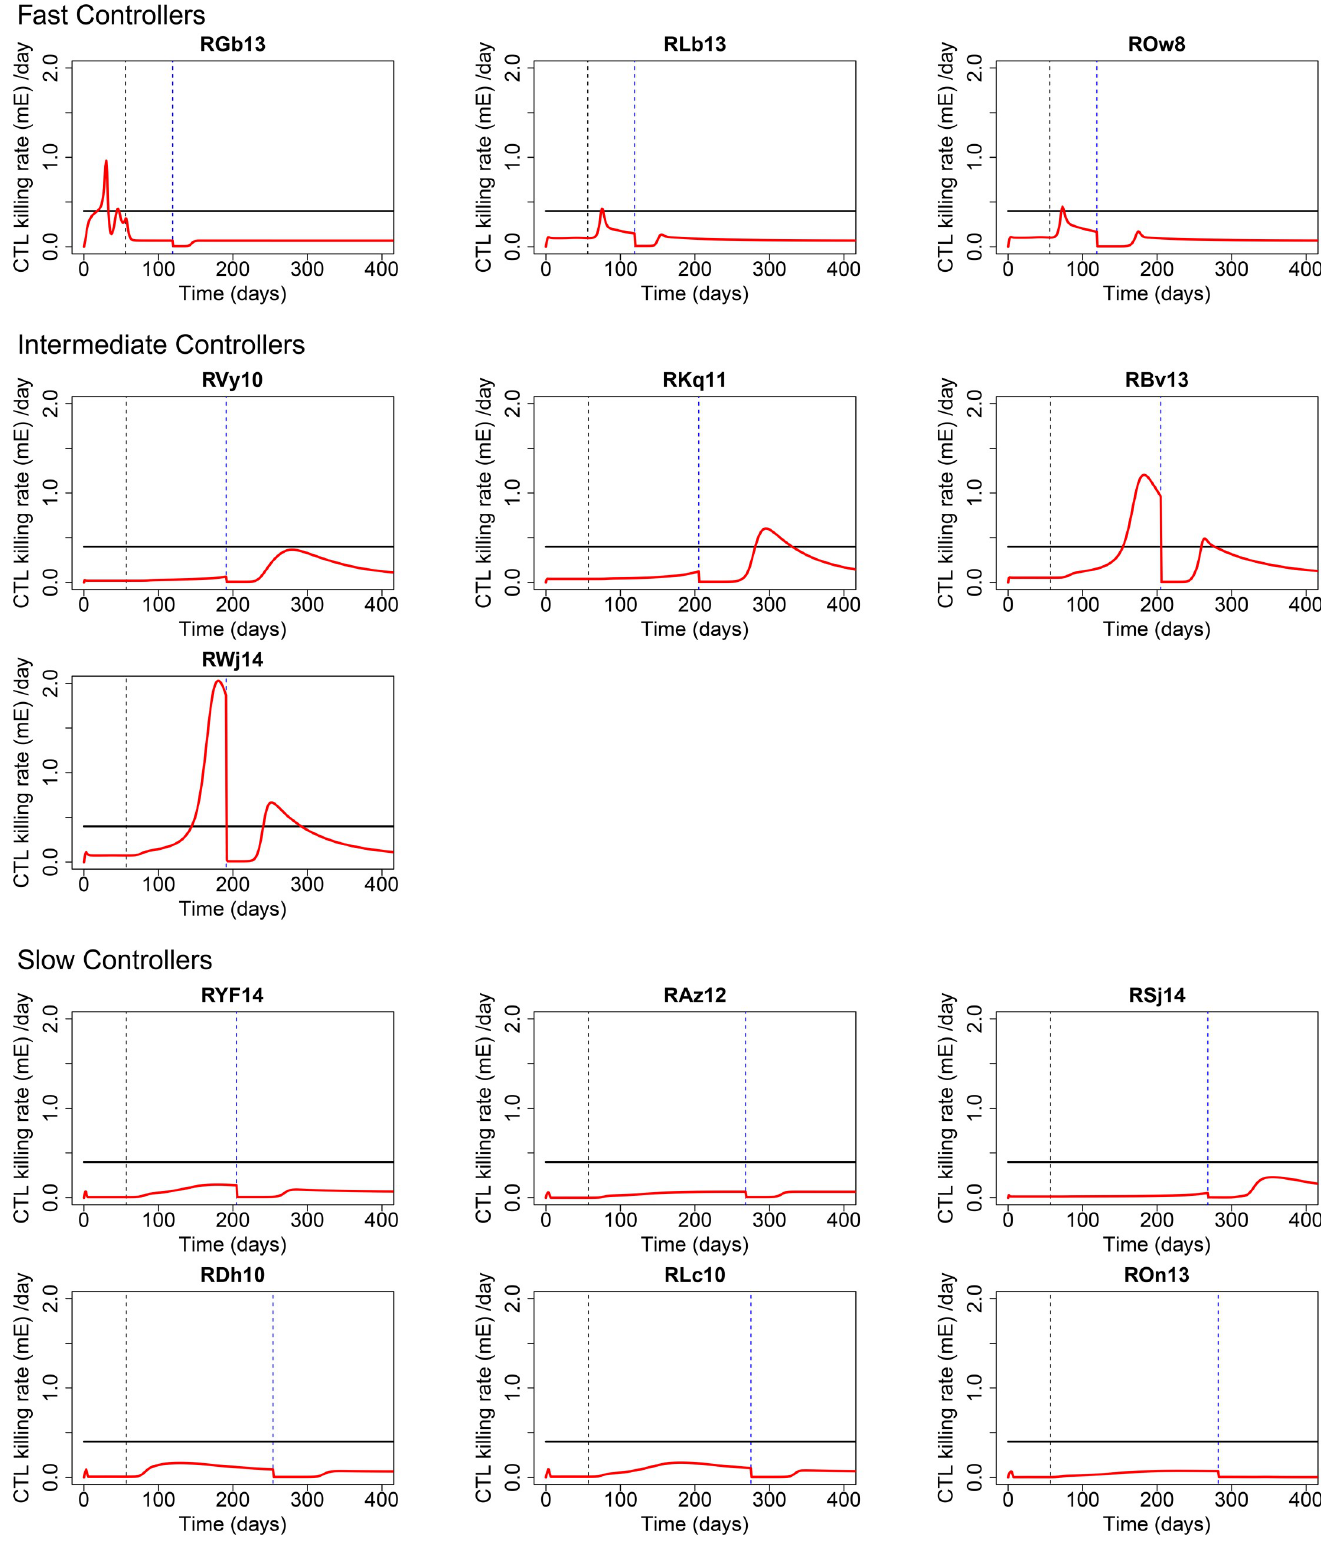
Fig 5. Predicted CD8 cytolytic killing rates, mE , (red lines) from the CTL-VC model. The black horizontal lines indicate the fixed cytopathic death rate of infected cells, δ = 0.40 d − 1 . https://doi.org/10.1371/journal.ppat.1007350.g005 PLOS Pathogens| https://doi.org/10.1371/journal.ppat.1007350 October 11,